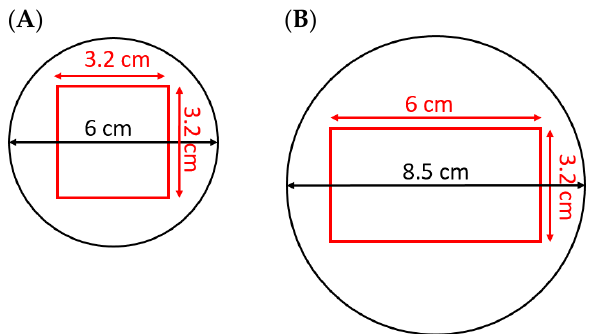
Figure 2. Teflon plates used under the gellan gel samples during microwave heat processing for ( A ) vertical and ( B ) horizontal orientations.